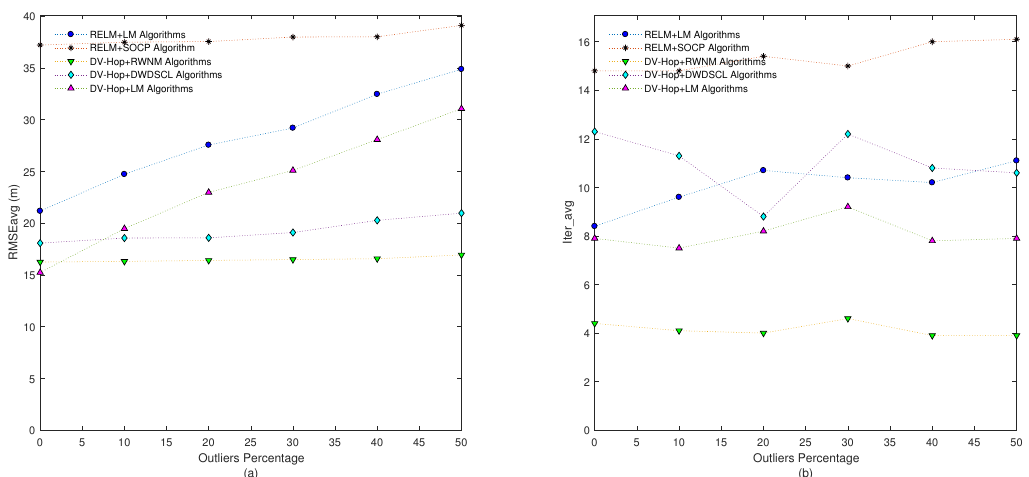
Figure 8. ( a ) RMSEavg and ( b ) Iter _ avg after running five iterative algorithms over 10 multi-hop anisotropic networks with R = 35 m and nfe = 0.1. Outliers levels are increased by steps of 10% from 0% to 50%.